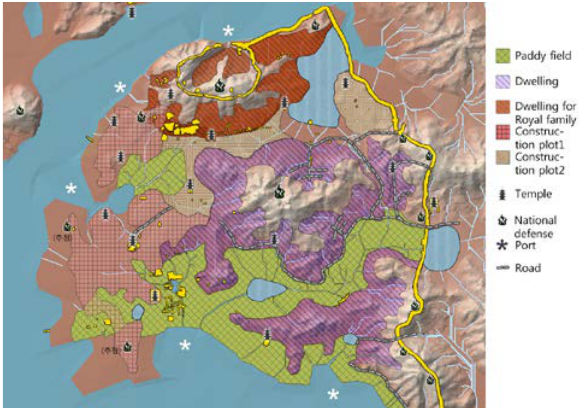
Figure 9. Land use in the ancient capital city, Sabi of